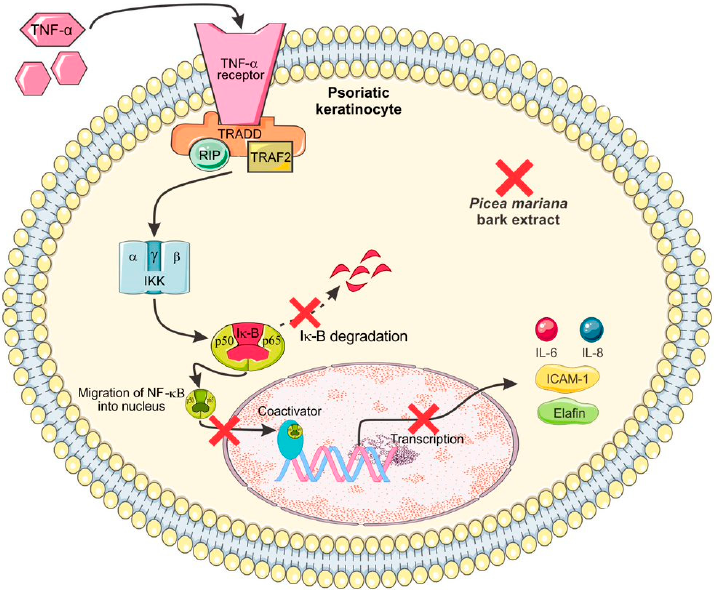
Figure 4. Mechanism of action of Picea mariana bark extract as a potential antipsoriatic treatment.